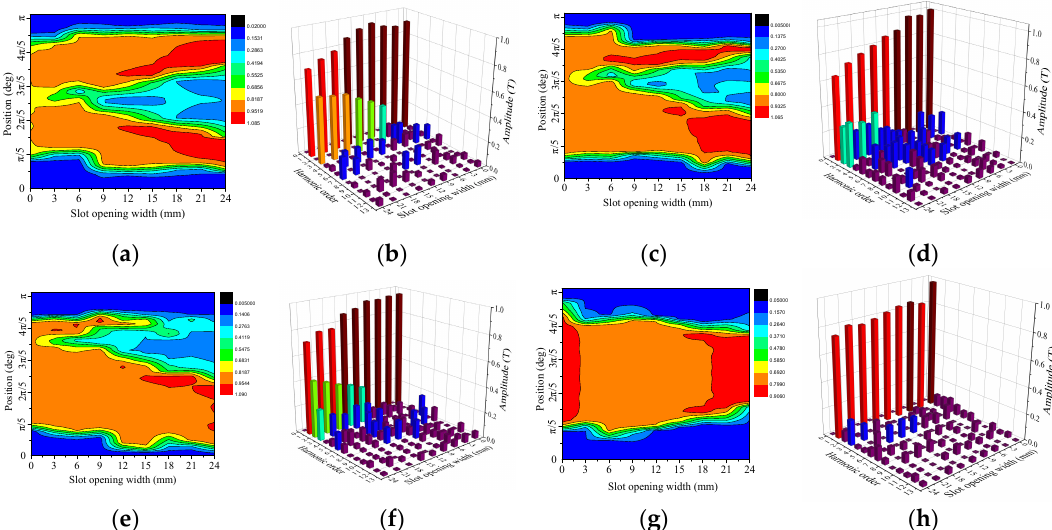
Figure 9. Air-gap magnetic field analysis of the DDPMM with eight poles and nine slots at di ff erent positions: ( a ) magnetic field distribution at position 1; ( b ) harmonics at position 1; ( c ) magnetic field distribution at position 2; ( d ) harmonics at position 2; ( e ) magnetic field distribution at position 3; ( f ) harmonics at position 3; ( g ) magnetic field distribution at position 4; ( h ) harmonics at position